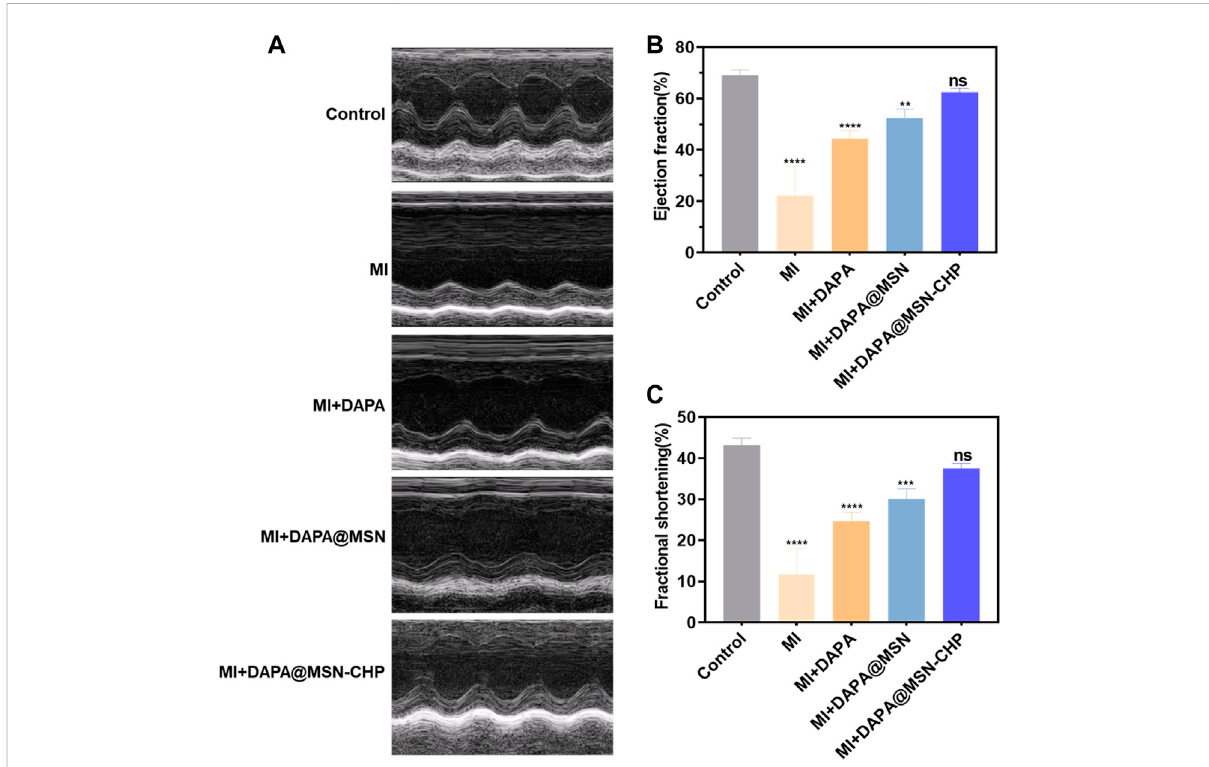
FIGURE 4 M-mode echocardiogram representative images of MI, MI + DAPA, MI + DAPA@MSN and MI + DAPA@MSN-CHP treatments. The healthy mice weresetascontrols (A) .EstimationofthefunctionofMIheartsbyejectionfraction (B) andfractionalshortening (C) afterMI,MI+DAPA,MI+DAPA@ MSN and MI + DAPA@MSN-CHP treatments. The healthy mice were set as controls. All error bars represent mean ± SD ( n = 4). Data analysis was performed via one-way ANOVA, ** p < 01, *** p <